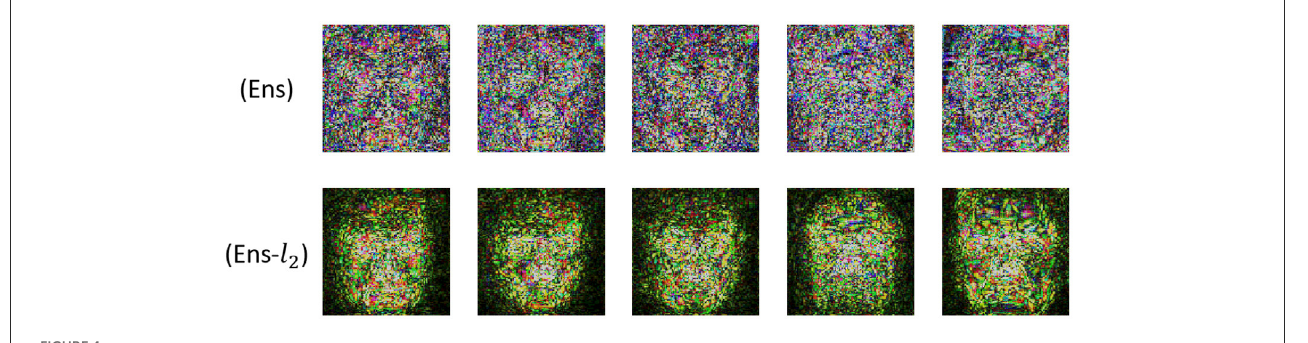
FIGURE4 The adversarial perturbation noise images for Ens and Ens- l 2 with I-FGSM.